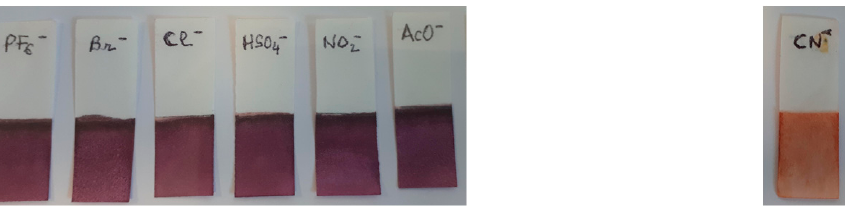
Figure 13. Qualitatively naked eye sensing of cyanide anions (right side) with a paper test strip treated with compound 7 . Color of the paper test strip (left side) in presence of other anions.